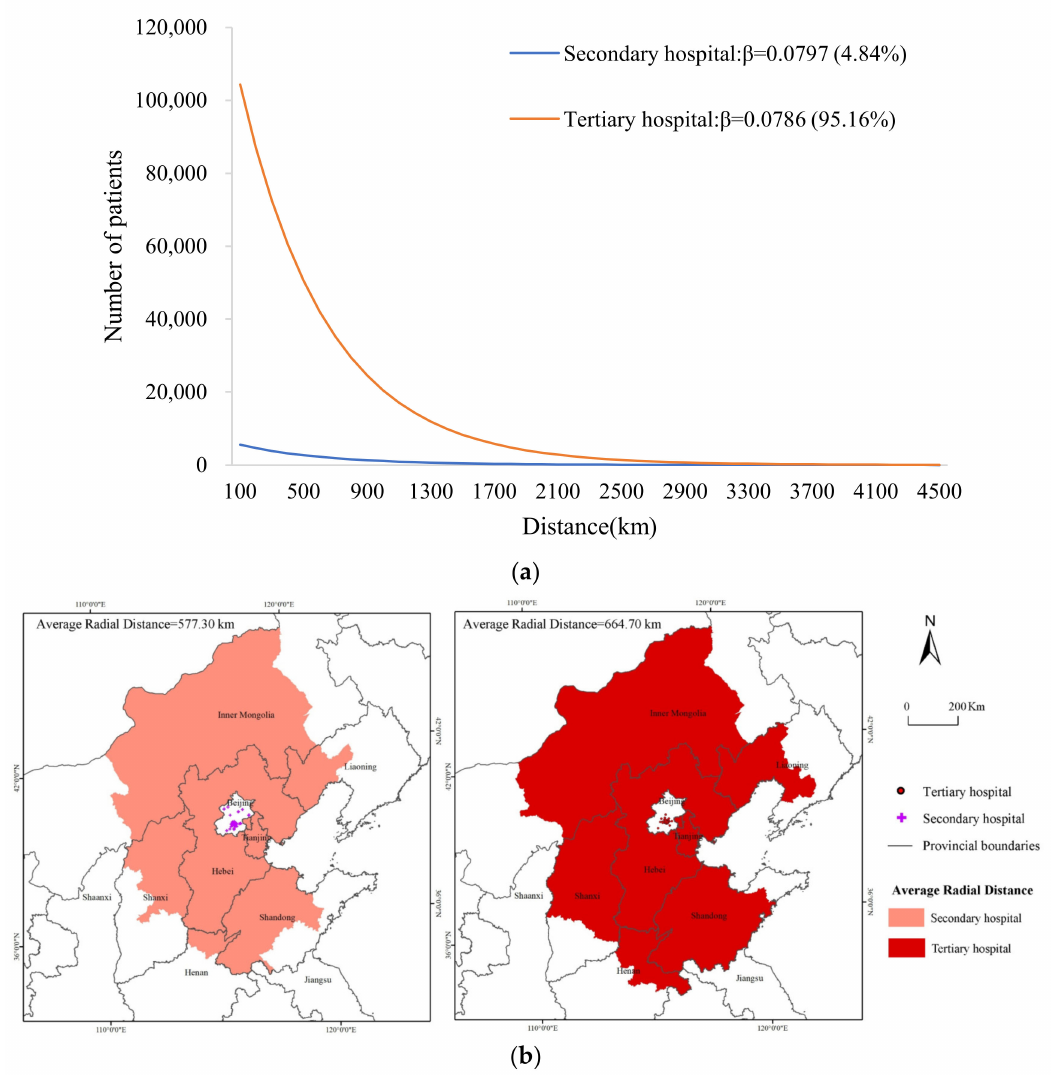
Figure 3. Hospital service utilization at different levels. ( a ) Fitting graph of the number of cross- regional patients according to distance in hospitals at different levels. ( b ) The AR of hospitals at different